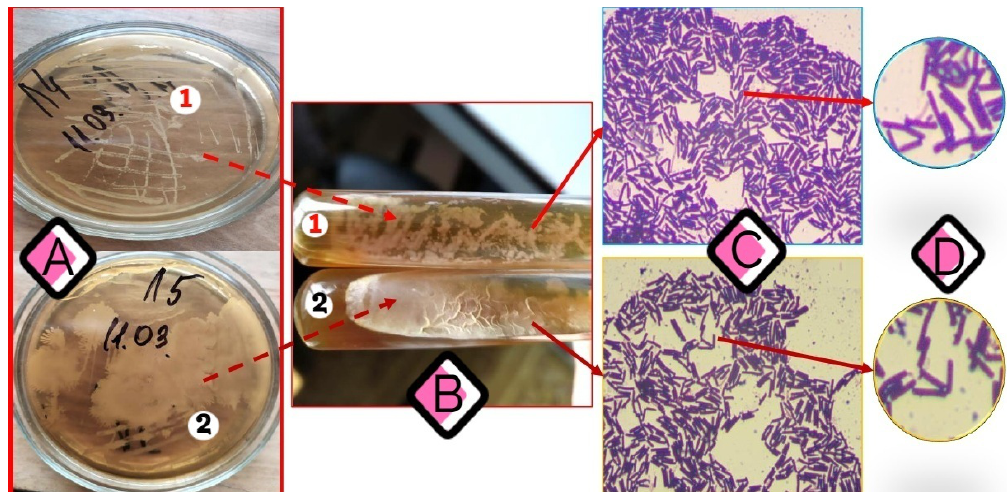
Fig. 3. Growth of pure isolates of Bacillus subtilis on MRS medium (de Man, Rogossa and Sharpe). (A) 24-hour cultures of Bacillus subtilis in Petri dishes (1. isolates of forest honey; 2. isolates of acacia honey), (B) growth of Bacillus subtilis isolates on oblique MRS agar, (C) view of pure cultures of antagonist bacteria under microscopy (Gram method) x 1000, (D) view of pure cultures of antagonist bacteria under microscopy (Gram method) x